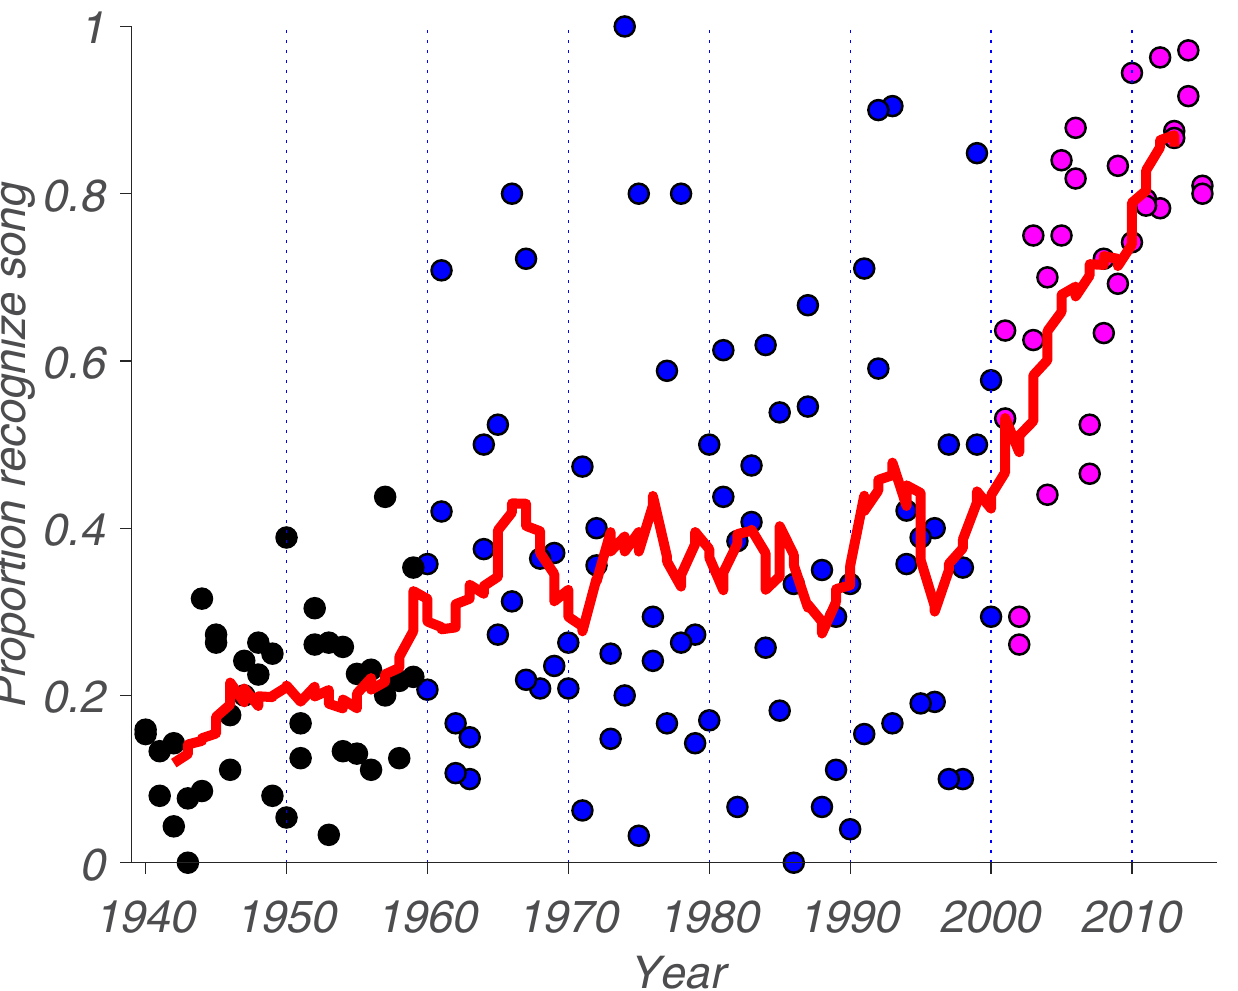
Fig 1. Recognition of songs over time. Dots represent the proportion of participants who reported to recognize a given song from a given year. The red curve represents the convolved average proportion for a given year, integrating over 5 years. Magenta dots represent songs from Phase 1 (2001 to 2015), blue dots represent songs from Phase 2 (1960 to 2000) and black dots represent songs from Phase 3 (1940 to 1959). Dashed vertical lines are decade markers.